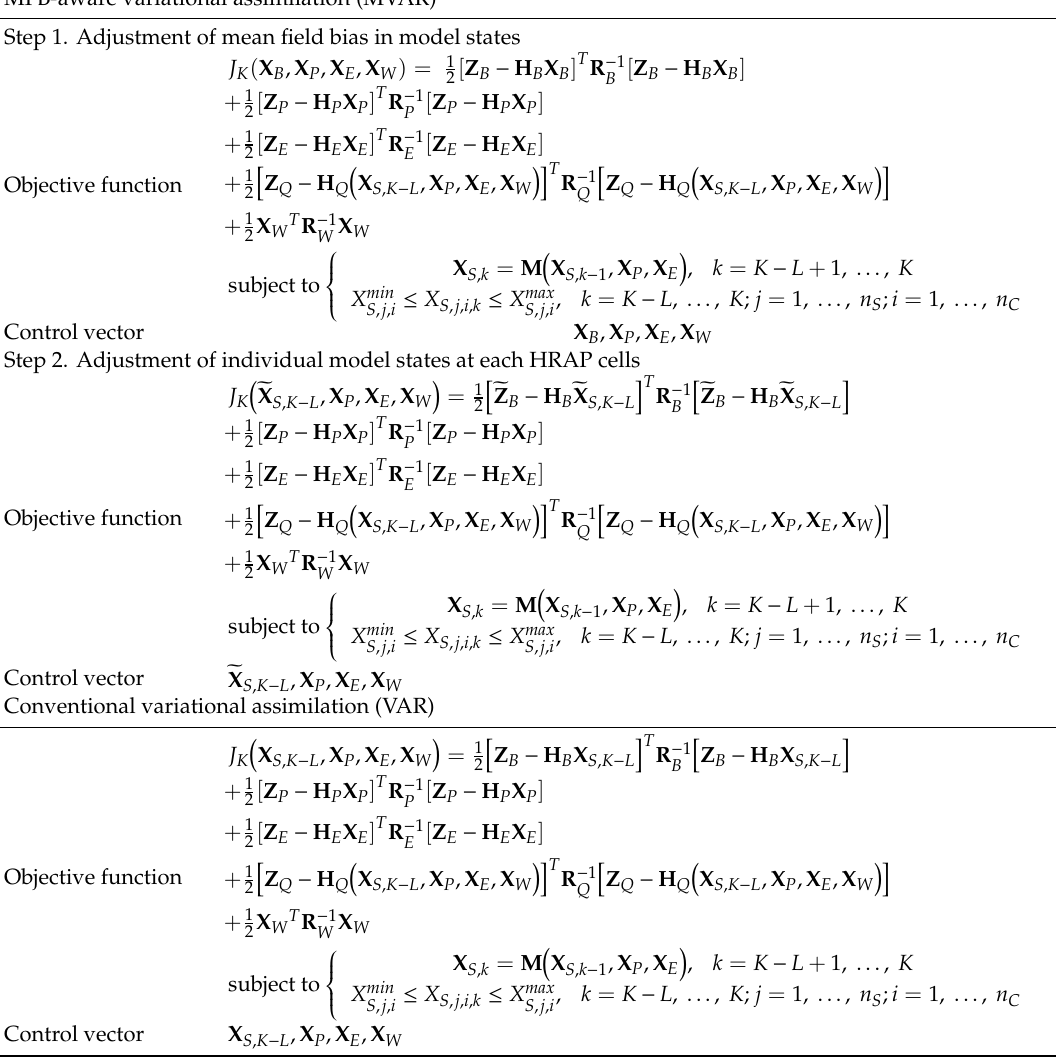
Table 2. Comparison of objective functions used in MVAR and